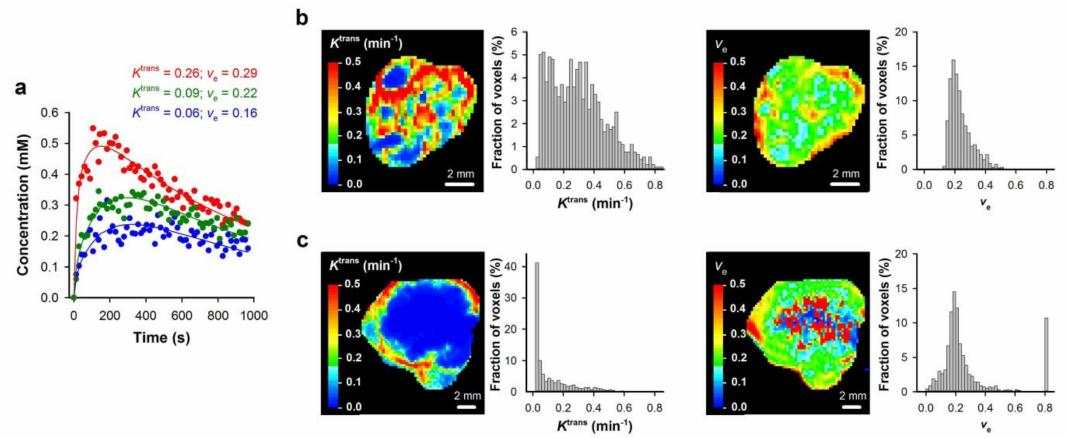
Figure 2. DCE-MRI series were analyzed on a voxel-by-voxel basis by using Tofts standard pharmacokinetic model and a population-based arterial input function. ( a ) Plots of gadolinium diethylene-triamine penta-acetic acid (Gd-DTPA) concentration versus time and the corresponding pharmacokinetic model fits for individual voxels. ( b , c ) K trans image, K trans frequency distribution, v e image, and v e frequency distribution of a TS-415 ( b ) and a CK-160 ( c ) cervical carcinoma xenograft. Modified from Ellingsen et al.